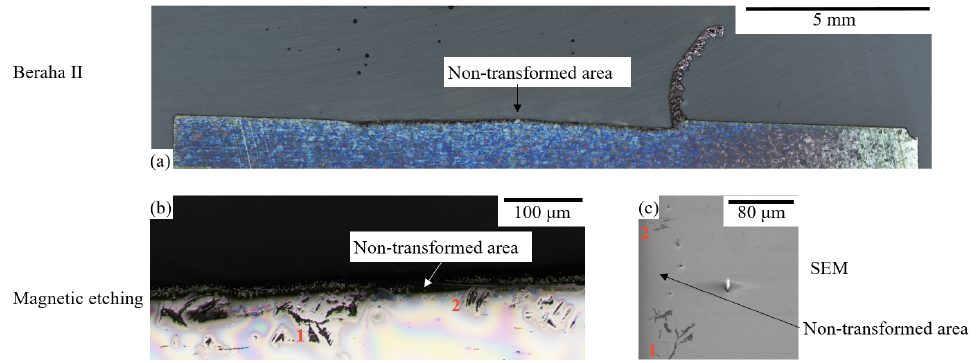
Figure 10. Microstructure analysis of specimen cut at room temperature: ( a ) Beraha II etching—a non-transformed grain (which is not black) is clearly visible, ( b ) magnetic etching, ( c ) SEM picture of the non-transformed grain for EBSD from ( a , b ). The regions labeled 1 and 2 mark the same areas in the different